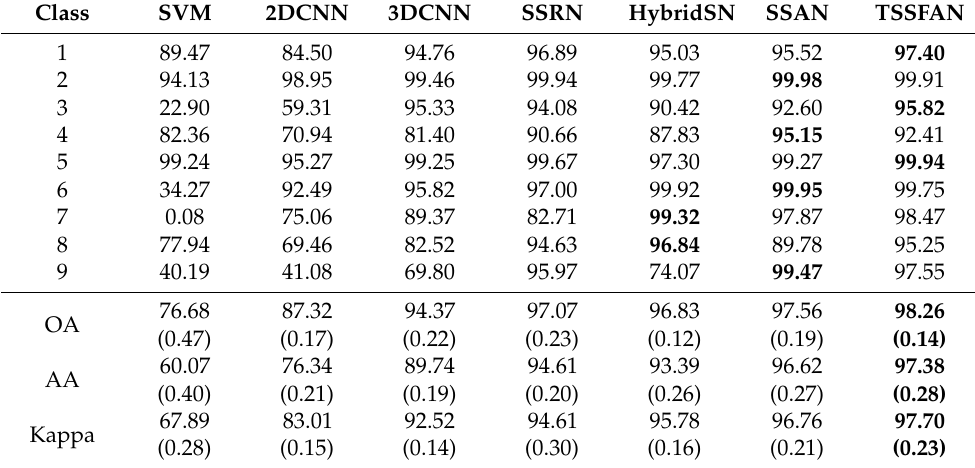
Table 6. Classification results of each method in University of Pavia (The bold format represents the best